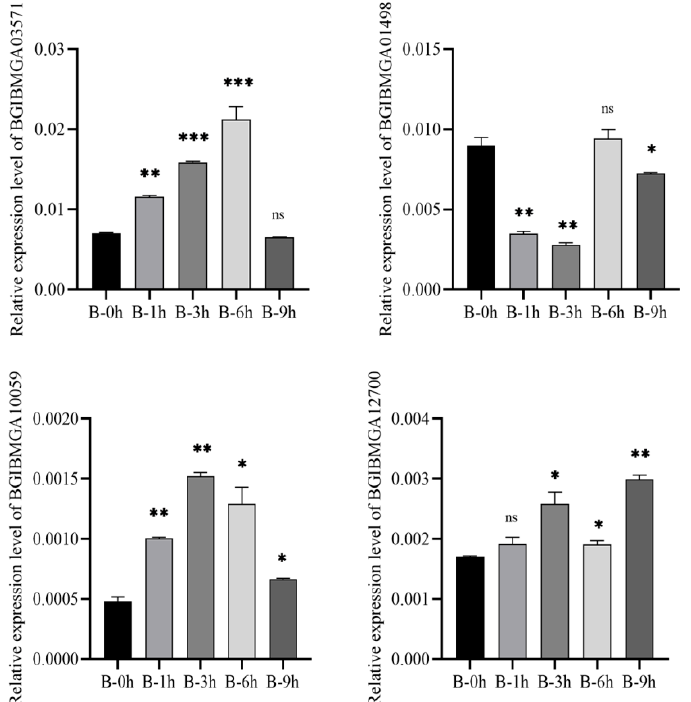
Figure 9. Quantification of identified four DEGs at 1, 3, 6, and 9 h after BmNPV infection in the B variety by qRT-PCR. Significant differences are indicated by asterisks ( p < 0.05). ns, not significant. *, p < 0.05; **, p < 0.01; ***, p < 0.001.